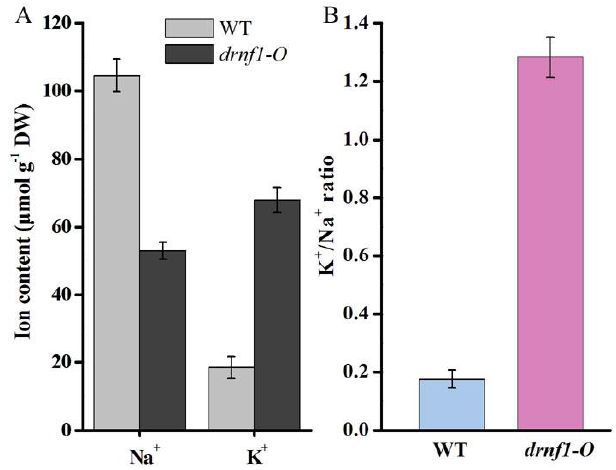
Figure 6. ( A ) The Na + and K + levels; and ( B ) K + /Na + ratios of salt-stressed WT and transgenic Synechocystis strains. 0.8 M NaCl was used for the stress treatment. Data are mean ± s.d. ( n =